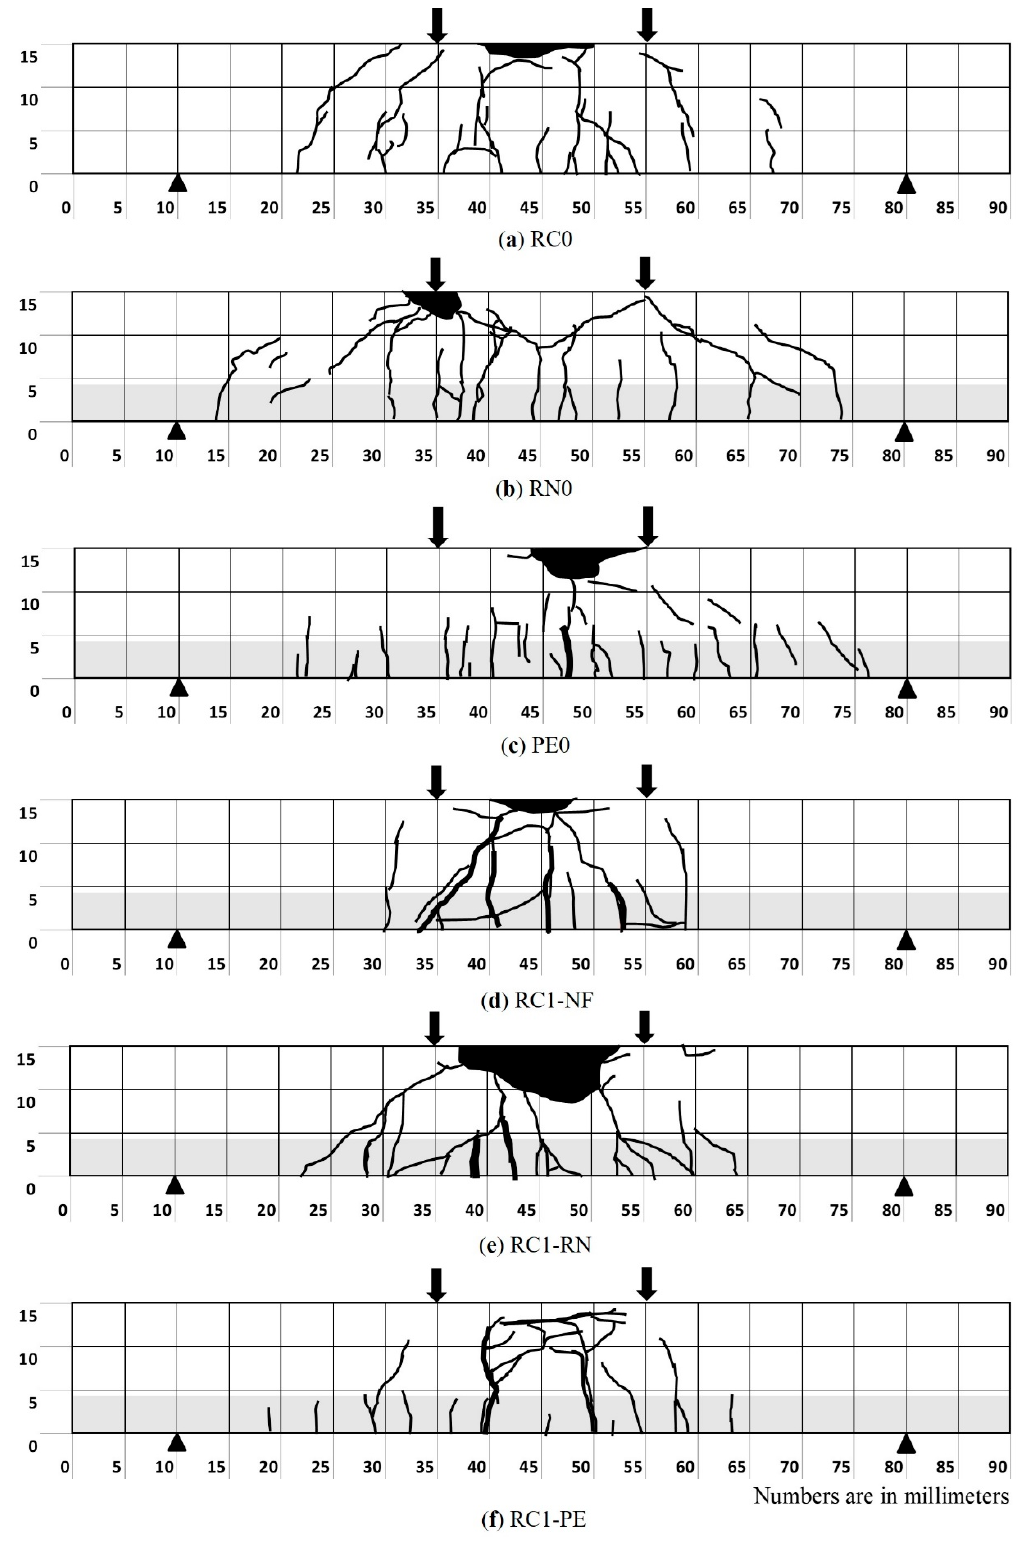
Figure 8. Final crack formation of the tested beams. ( a ) RC0; ( b ) RN0; ( c ) PE0; ( d ) RC1–NF; ( e ) RC1–RN; ( f ) RC1–PE.